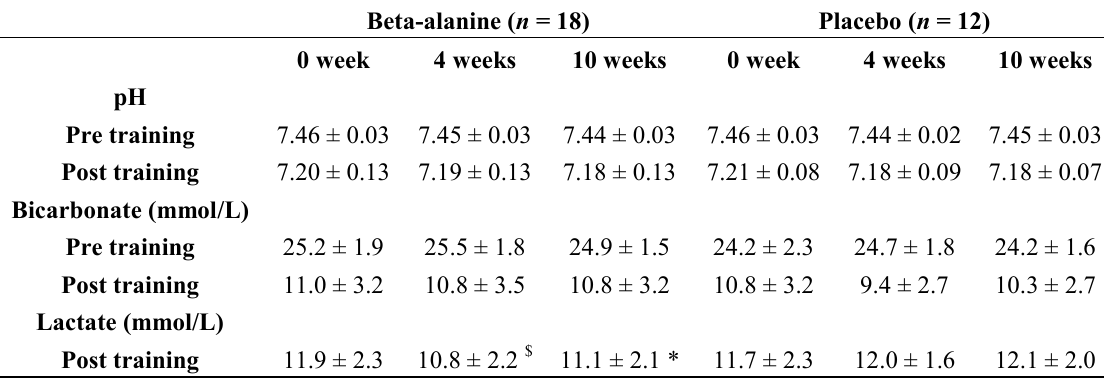
Table 3. No substantial effect of BA on pre and post training values of blood pH, bicarbonate and lactate at baseline, 4 and 10 weeks post supplementation. A total of 30 blood samples were analyzed for pre and post training